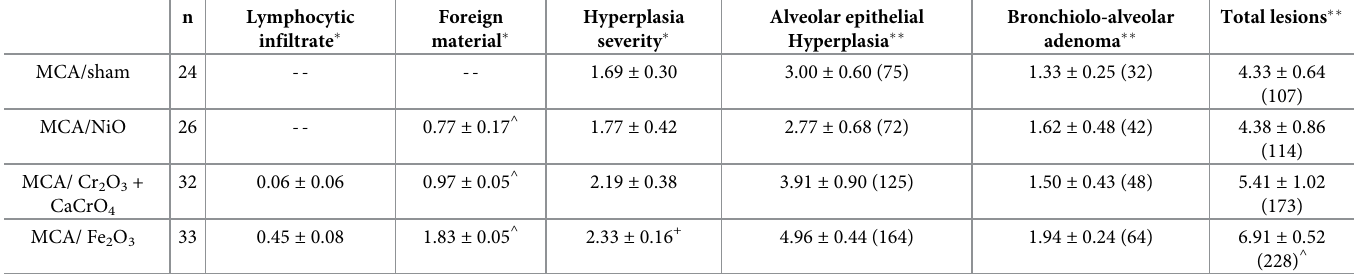
� Severity scores are the averages of the left and right lung lobes and presented as means ± standard error. Severity was scored as 1 = minimal, 2 = mild, 3 = moderate, 4 = marked. �� Hyperplasia and adenoma were the only two lung lesions present and represented as count data presented as average or total lesions (in parenthesis). --Indicates no findings ^ p < 0.0001 compared to MCA/sham